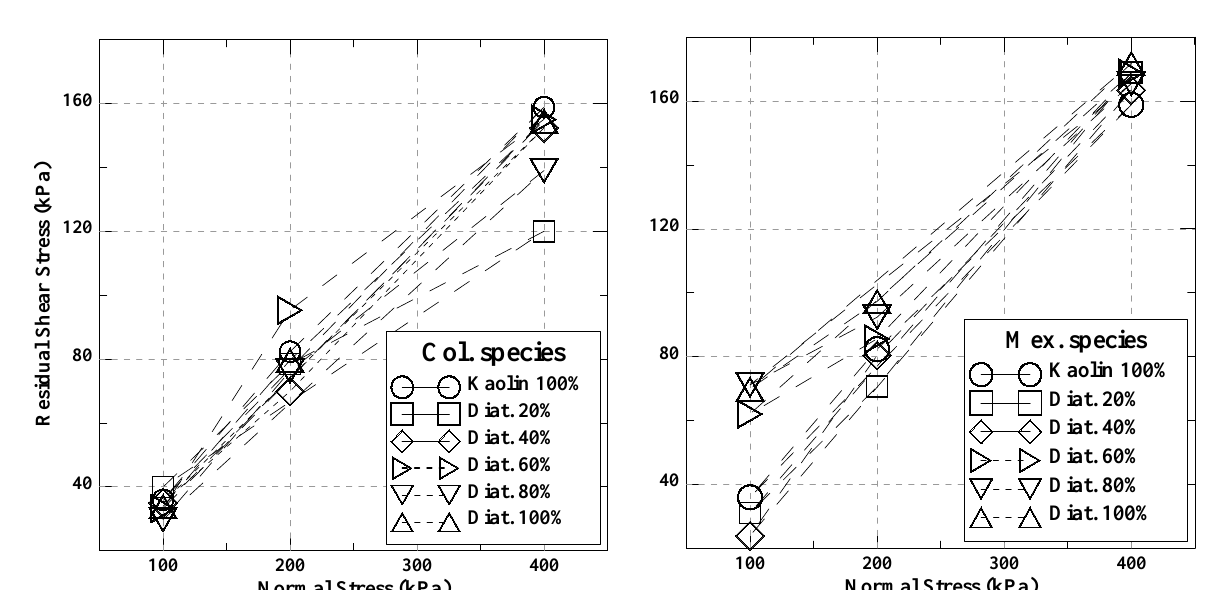
that this diatomite leads to an increase in the residual friction angle at a higher rate than the friction angle. On the other hand, the variation of the friction angle was higher as the Mexican diatomite content increased. Although the addition of Mexican diatomite may increase both peak and residual friction angles, the growth rate is greater for the peak rather than the residual one.